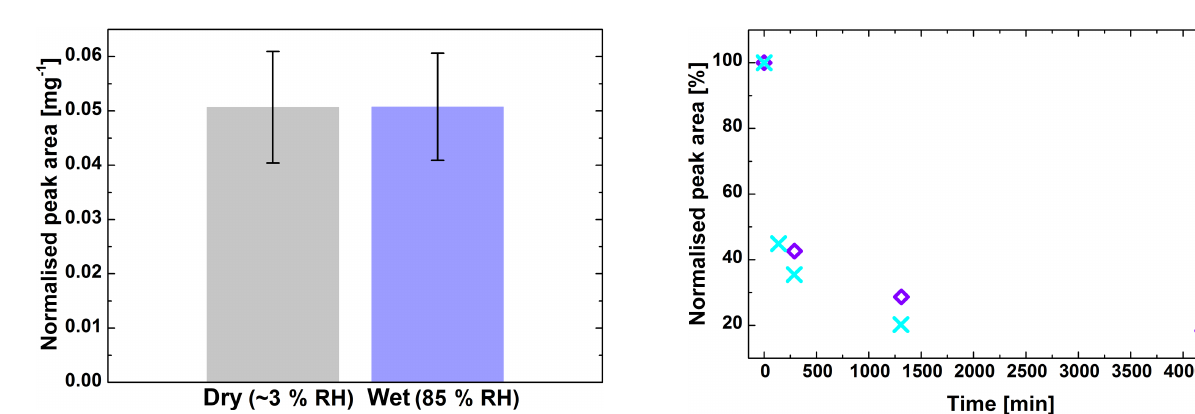
Figure 5. Degradation of monoperoxypinic acid isomer II on the filter, illustrating its short lifetime of only a few hours. Diamonds and crosses represent two different repeats of the degradation ex-